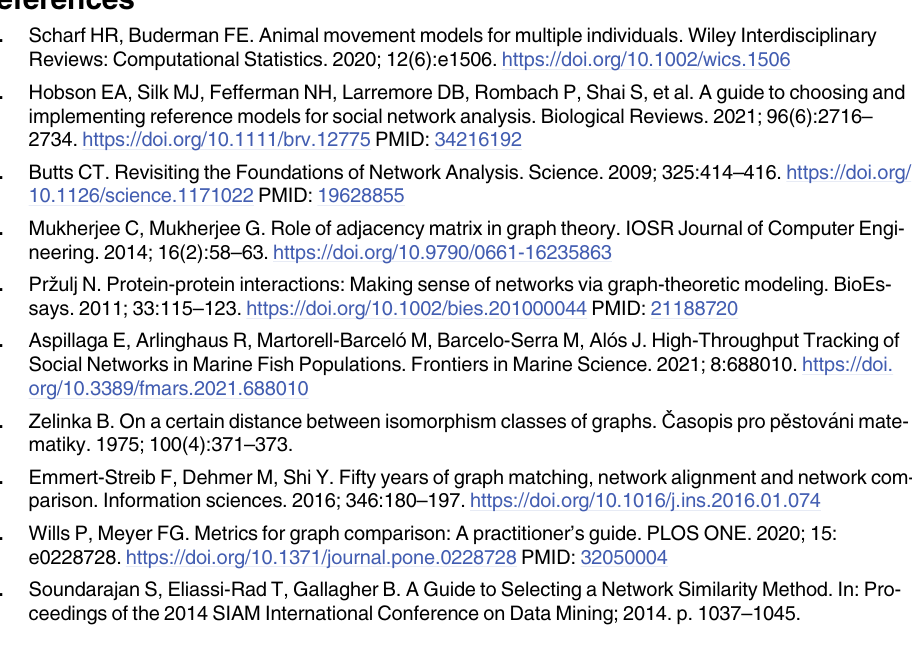
S1 Table. Estimated p-values (std). Each empirical graph is associated with an estimated p - value ð ^ p Þ of being an outcome of an Erd ő s-Re´nyi, Fitness scale-free model, a Watts-Strogatz small word or a Geometric model. As in Table 1, empirical graphs are sorted according to their order. ( ^ p � < 0 : 05 , ^ p �� < 0 : 01 and ^ p ��� � 0 : 001